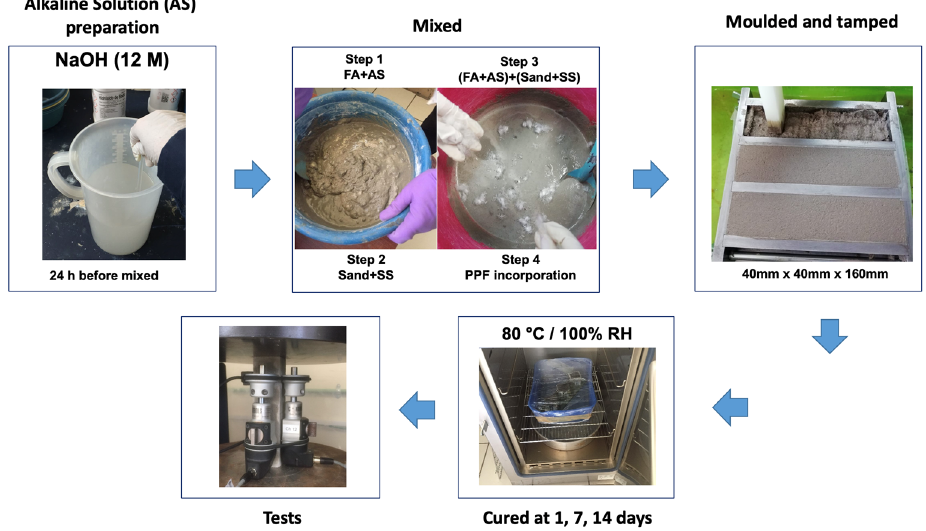
Figure 1. Test sample preparation procedure .